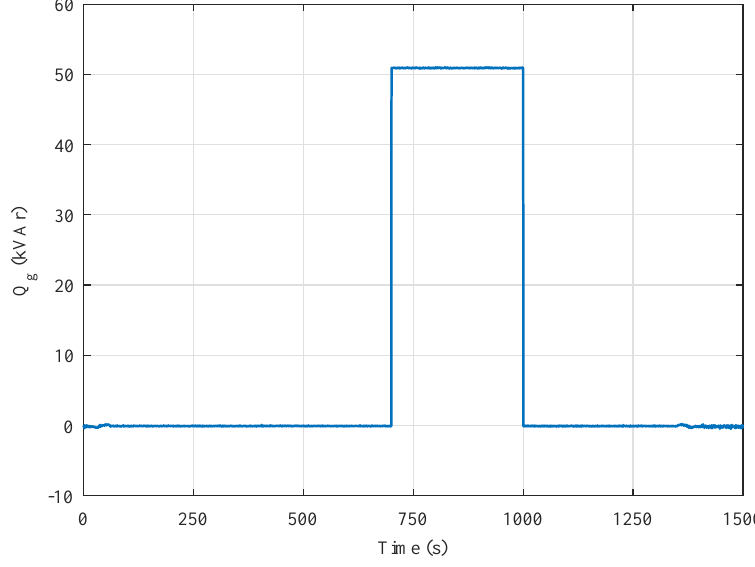
Figure 15. Time response of the total reactive power injected into the grid by the concentration photovoltaic (CPV)